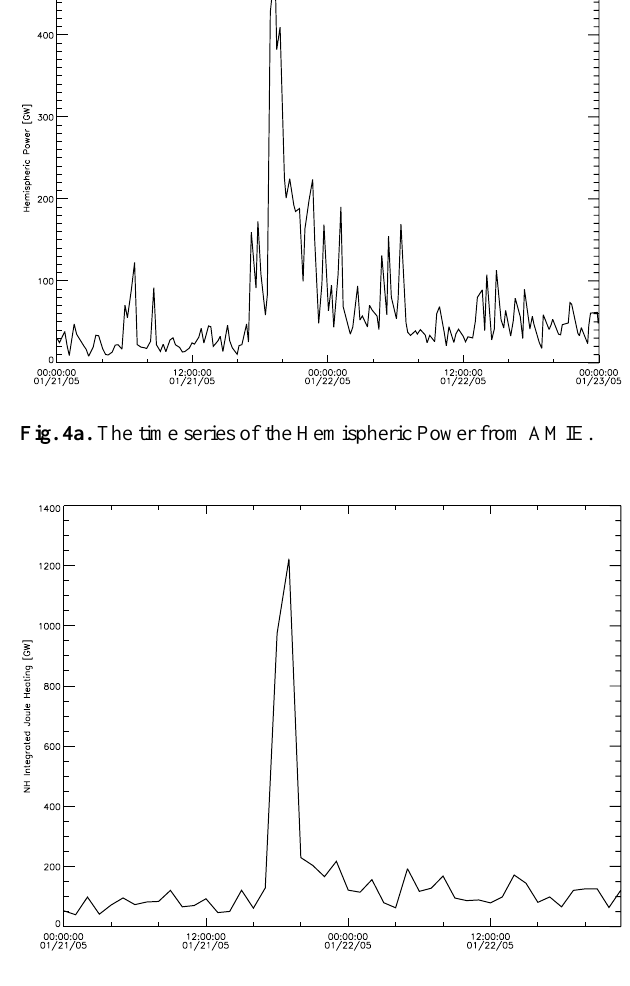
Fig. 4b. The time series of the hemispheric integrated Joule heating for the Northern Hemisphere from